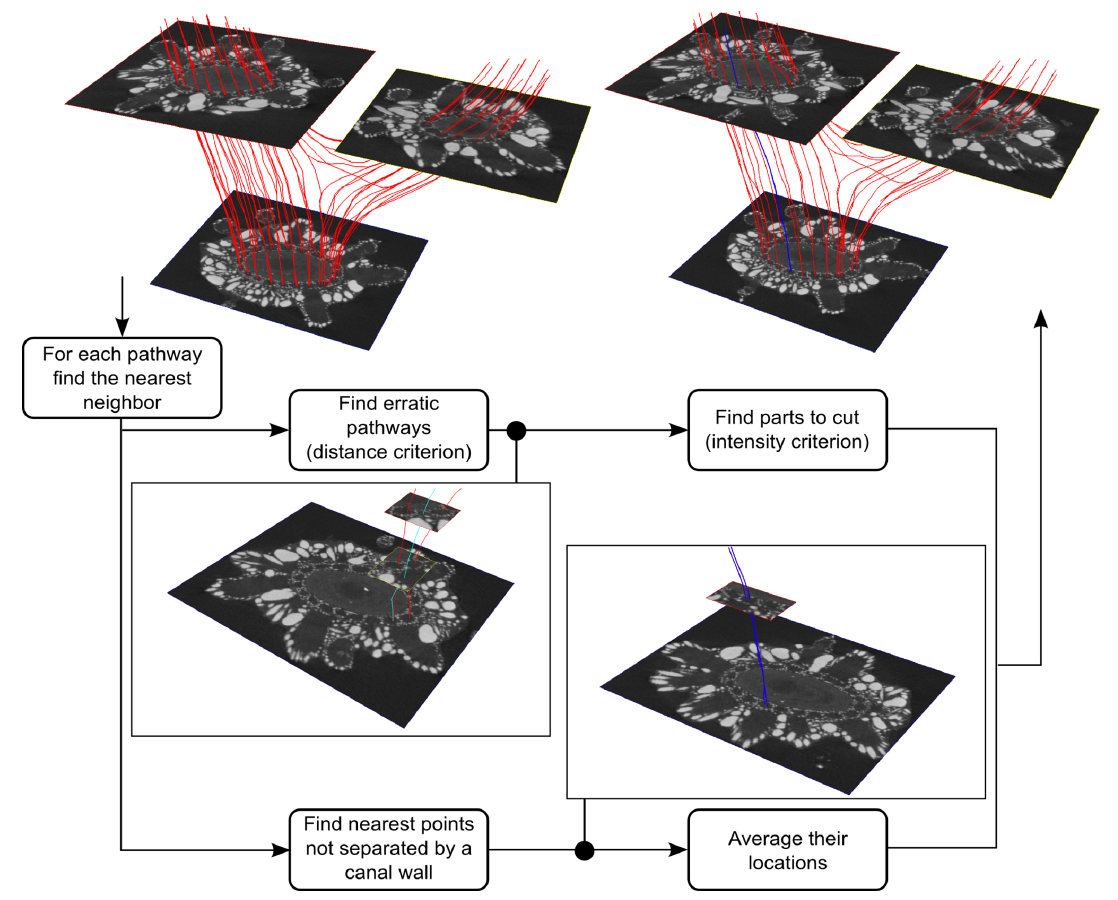
Figure 10. Flowchart of the post-processing.